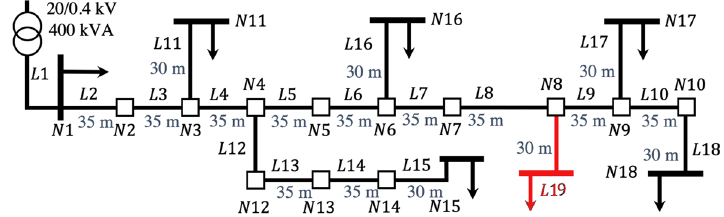
Fig. 3 Modified CIGRE LV grid used in the case study. The charging stations are connected at the bus R19. Figure adapted from (CIGRE’ Task Force